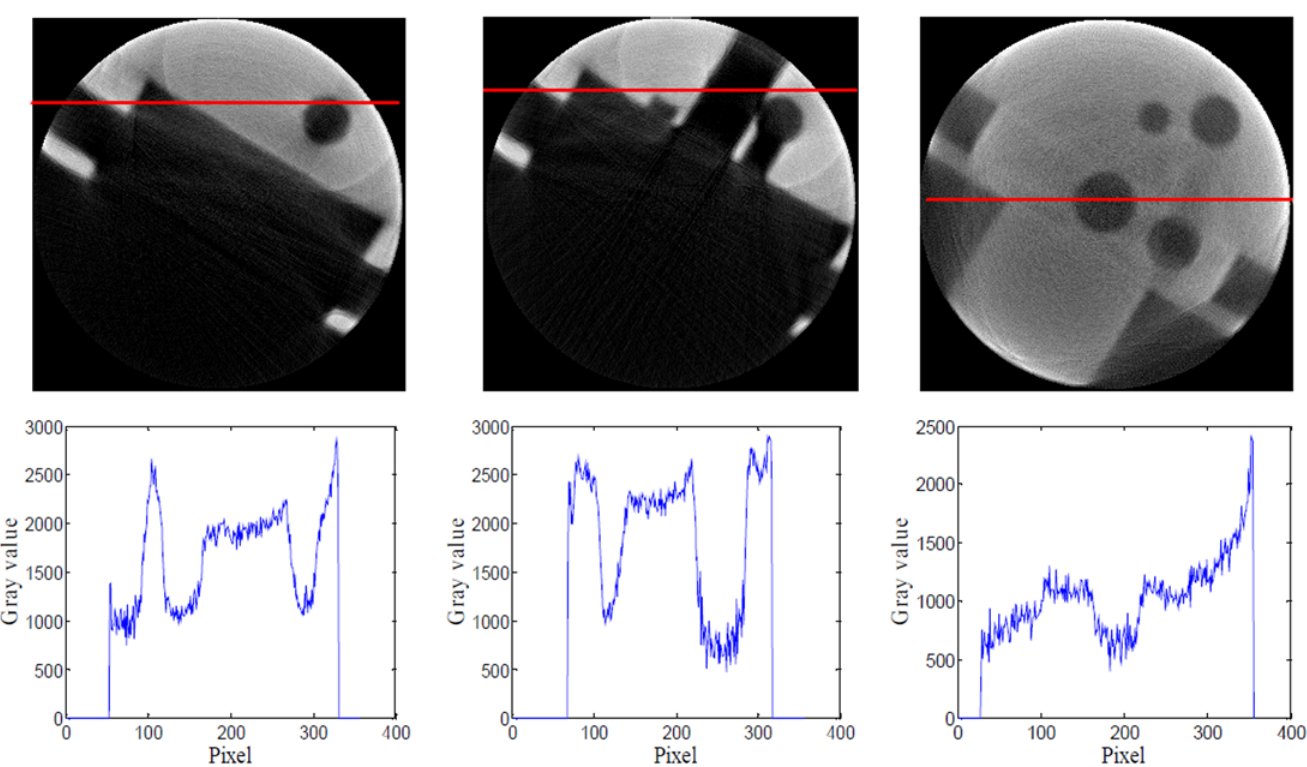
Fig 10. CT images obtained using the improved fused images. The first row CT image from left to right is corresponding to bottom, center and top about workpiece, The second row is respectively the gray curve at the indicated line. Relative to Fig 8, image quality and noise have major